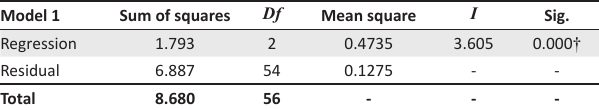
TABLE 9: ANOVA: Statistical significance of the model. Model 1